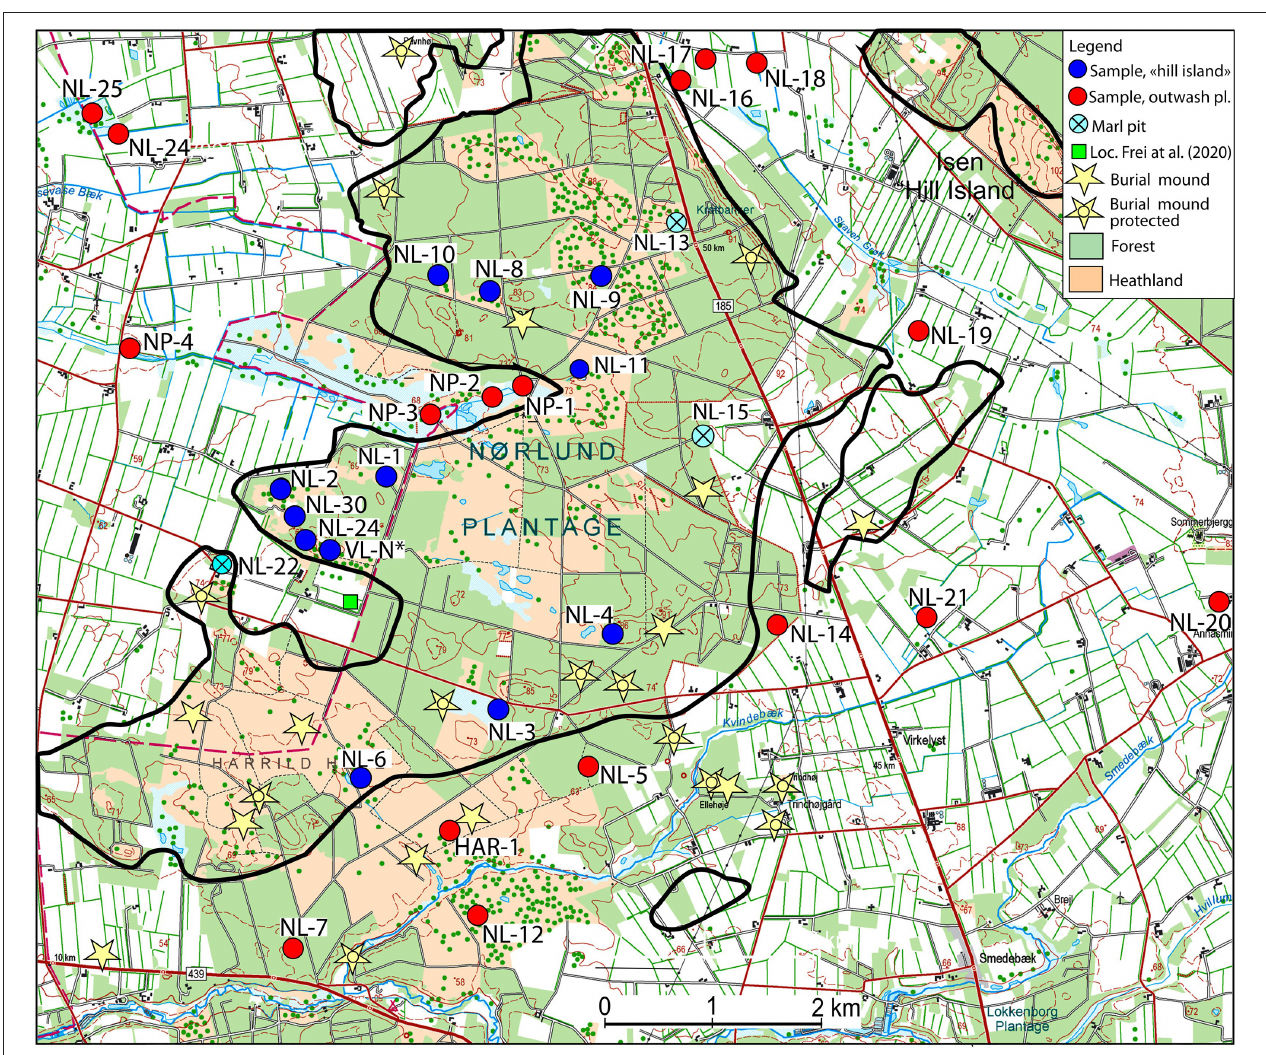
FIGURE 2 | Modern topographical map of study area S1, the Nørlund hill island and surrounding outwash plains. The outline of the “hill island” is transferred from Figure 3 and indicated with a black line. Sample locations are indicated by colored dots. Sample number and detailed information on location and laboratory data is given in Table 1 . Yellow stars mark location of preserved prehistoric burial mounds. See Figure 1A for location of study area. Location of the site investigated by Frei et al. (2020) is marked by a green square. Map is based on free data from “Styrelsen for Dataforsyning og Effektivisering, topografisk kort,